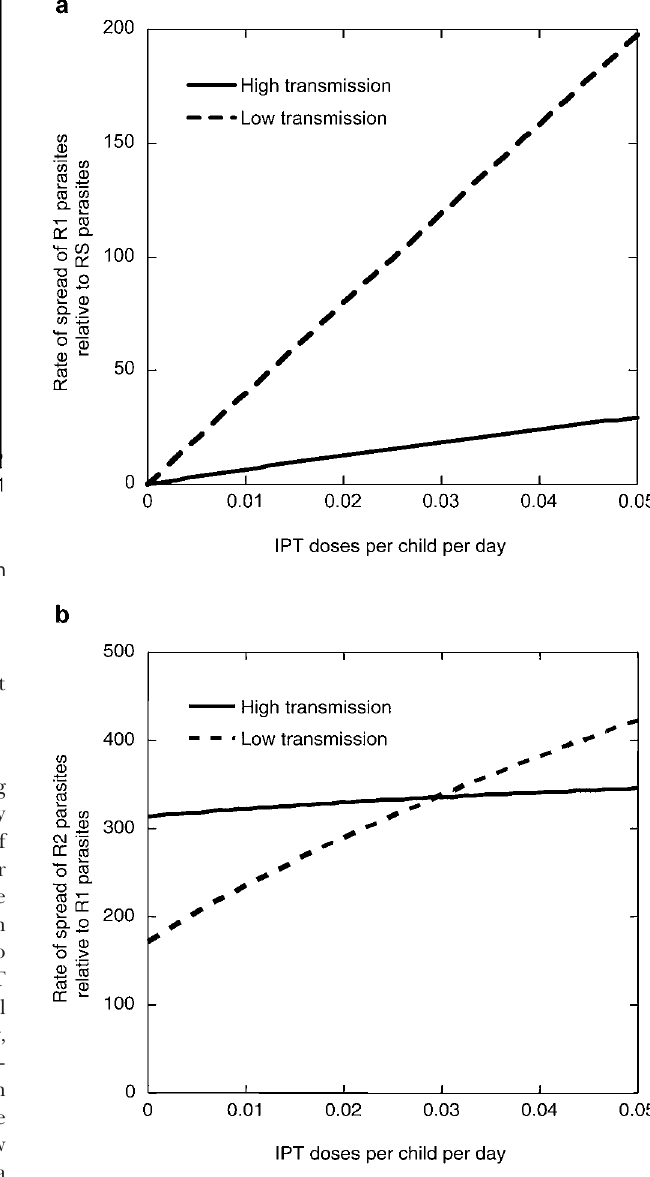
Figure 4. Effect of Increasing IPT Coverage with SP on the Percent Increase of R1 Relative to RS or R2 Relative to R1 Resistance Treatment effect is shown for percent increase of (A) R1 relative to RS or (B) R2 relative to R1 resistance. Increasing treatments of non-diseased individuals increases the relative spread of R1 and R2 resistance in low- transmission conditions (A and B) but only R1 resistance in high- transmission conditions (A). DOI: